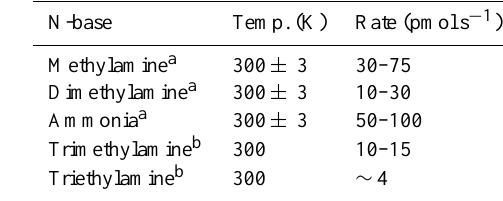
Table 1. Typical permeation rates at room temperature. N-base Temp.